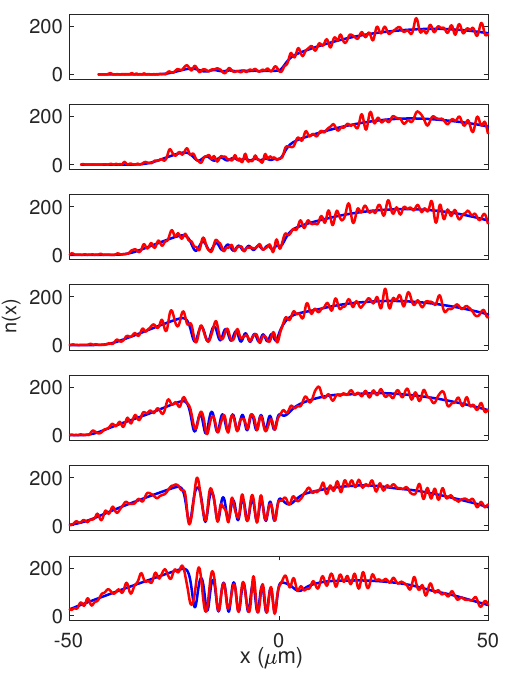
Figure 10: Comparison of condensate evolution with and without quantum fluctuations. Blue: GP simulation; red: a simulation with quantum noise obtained from the TWA method. The blue curves are the same as those in Fig.